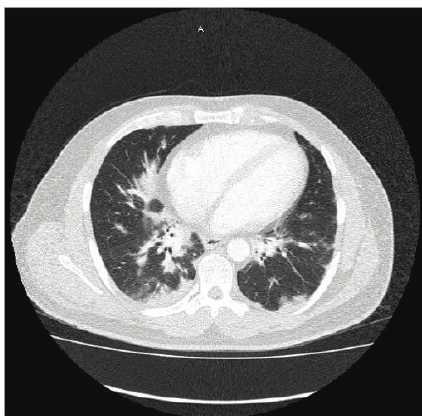
Figure 2: CT chest revealing bilateral basilar fibrosis along with reticulonodular and subpleural wedge shaped opacities.